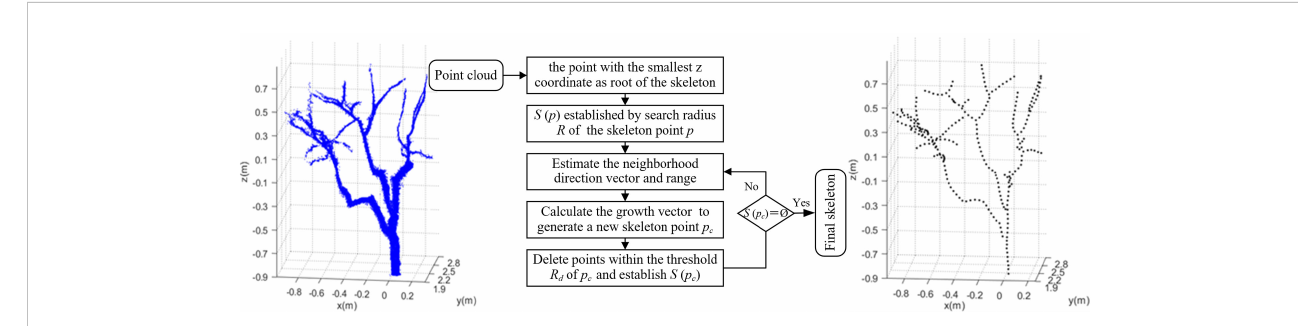
FIGURE 5 Flowchart of skeletonization using space colonization